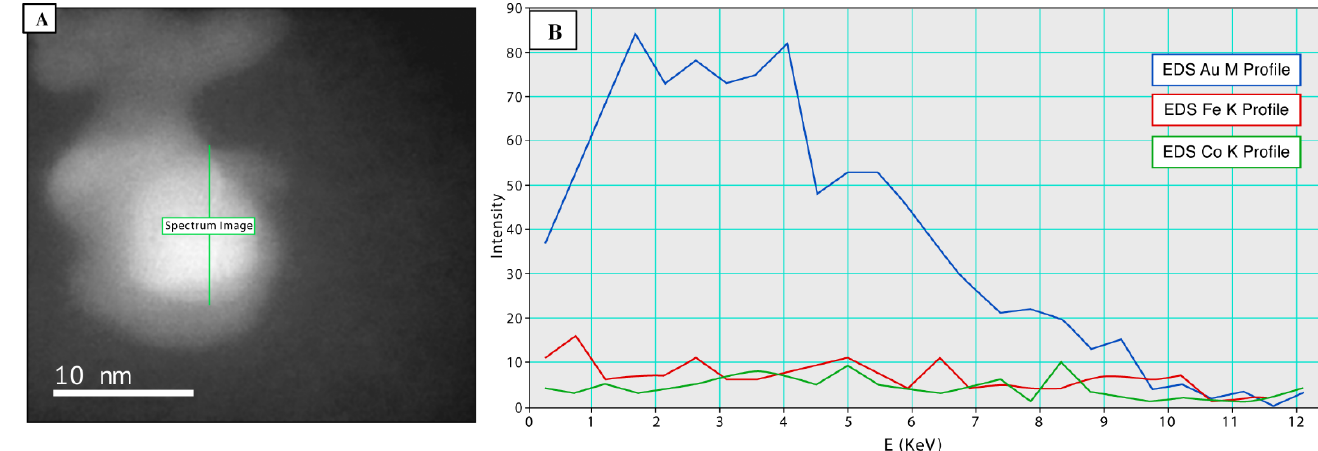
Figure 6. ( A ) HAADF imaging, Au-CoFe 2 O 4 TX-100 0.1 M CTAB 0.1 M. ( B ) Core-shell scan mapping revealing a Core-shell nanoparticle, Au as a shell and Co-Fe as a Core.